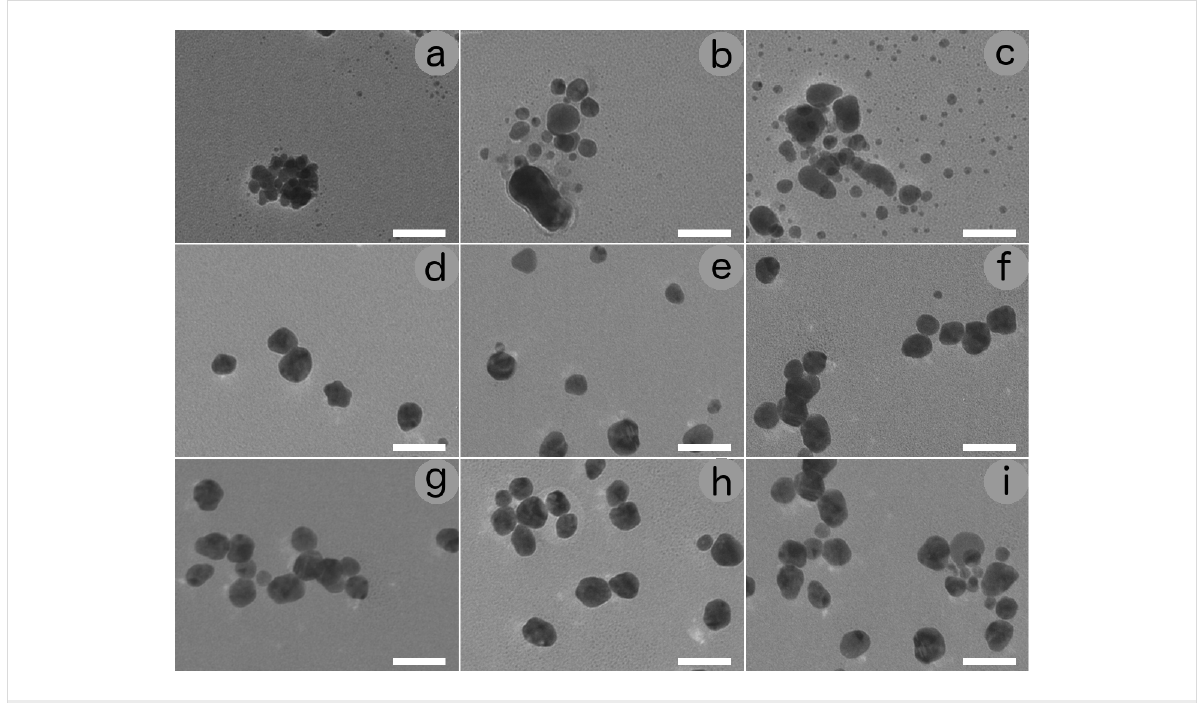
Figure 3: TEM images of AgNPs obtained at different NH 3 concentrations: (a) without ammonia, and (b–i) with 0.01, 0.1, 1, 5, 10, 100, 1000 and 2000 ppm ammonia. Scale bar: 50 μ m.